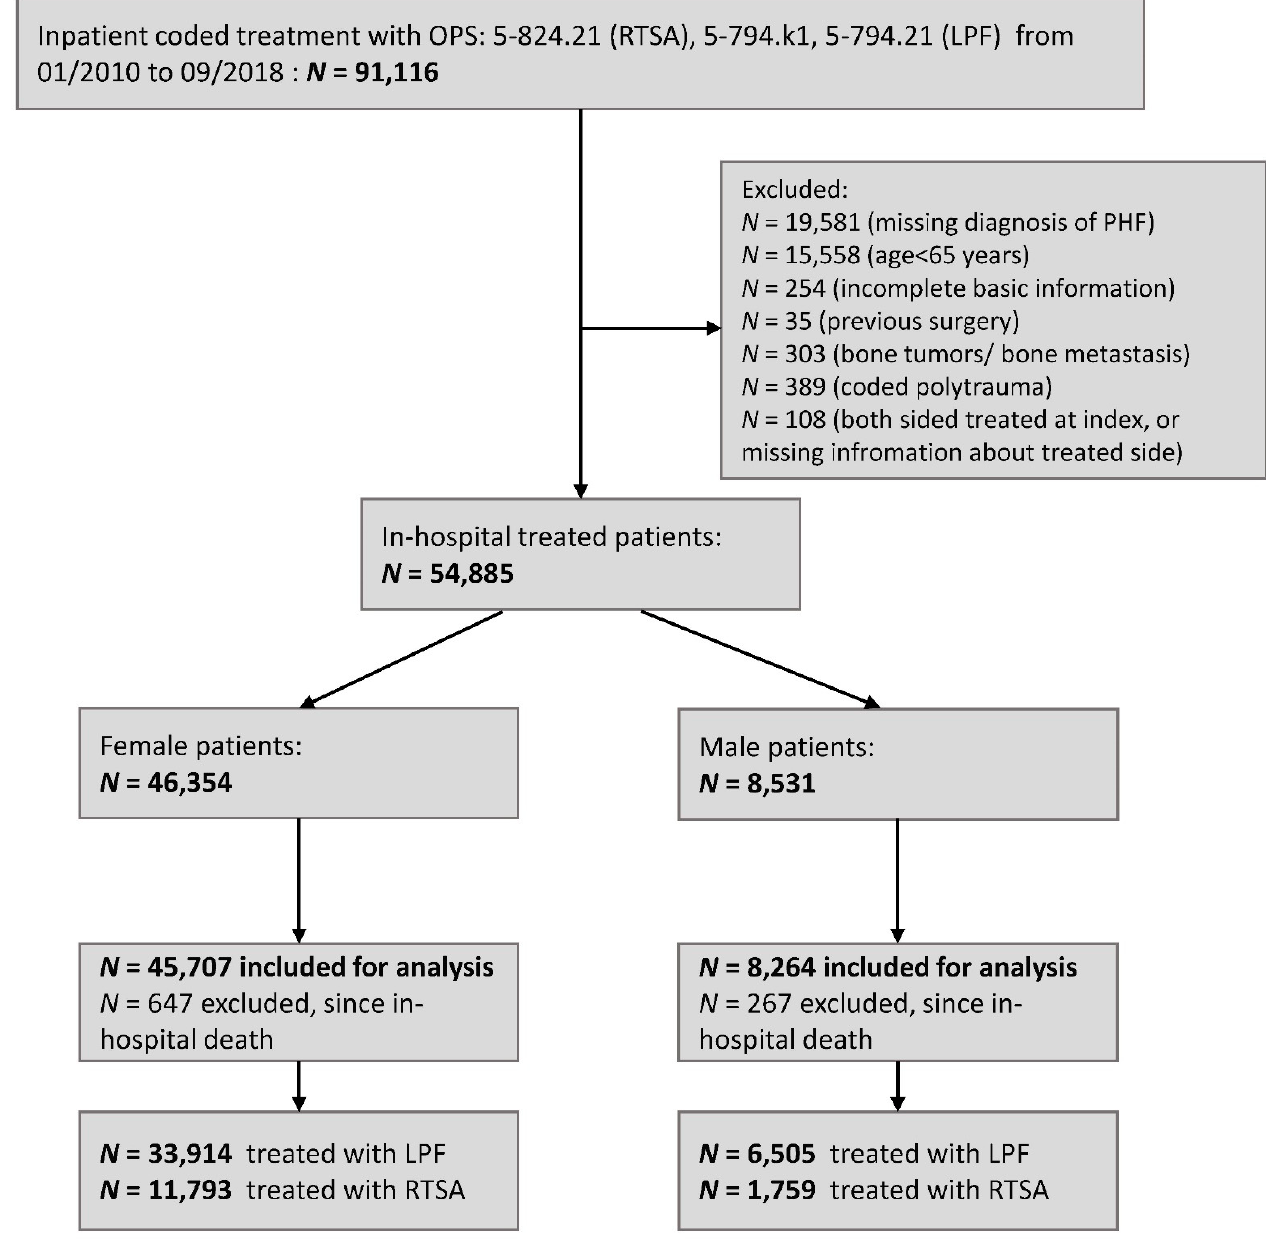
Figure 1. Flow diagram. Locked plate fixation—LPF, proximal humeral fracture—PHF, reverse total shoulder arthro- plasty—RTSA.